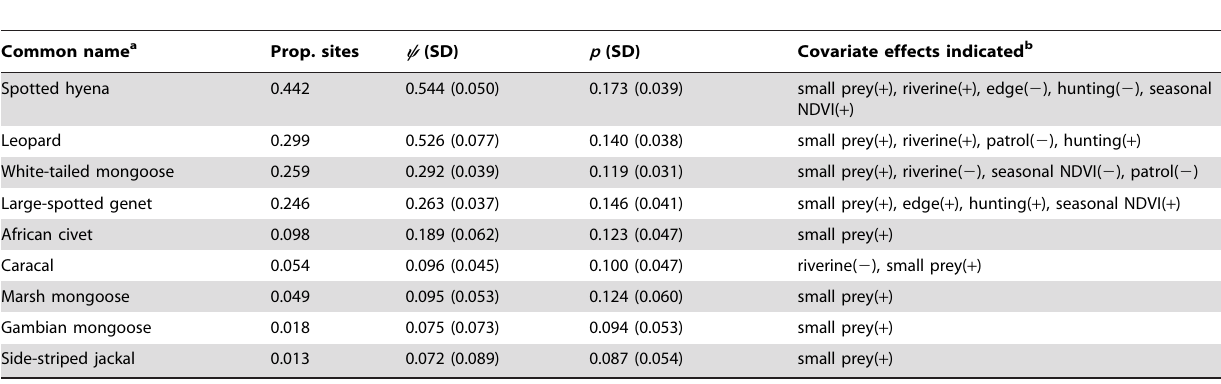
Table 2. Carnivore species detected during the camera trap survey in Mole National Park, Ghana, and estimated mean occurrence ( y ) and detection ( p ) probabilities and covariate effects on occurrence.